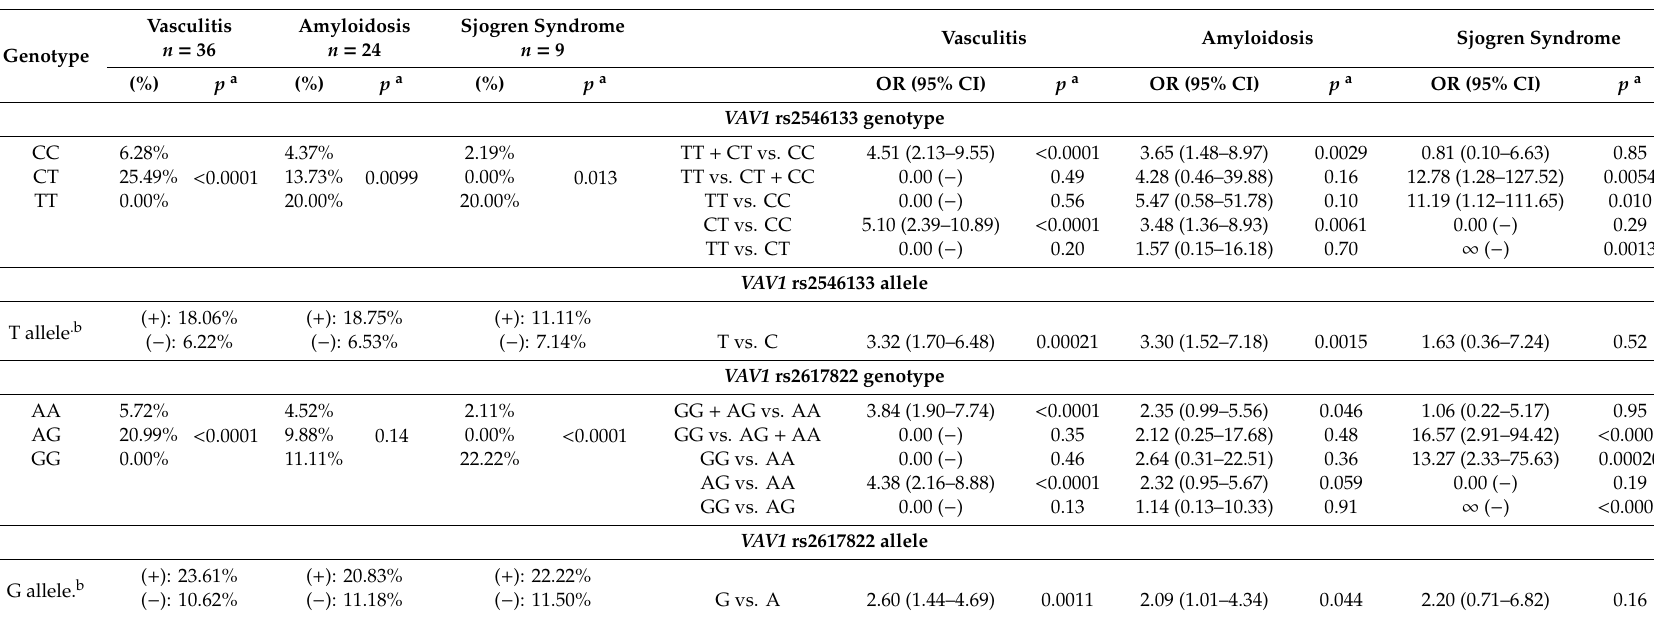
Table 6. Analysis of extraarticular manifestations (vasculitis, amyloidosis and Sjogren syndrome) in relation to VAV1 rs2546133 and rs2617822 genotypes.